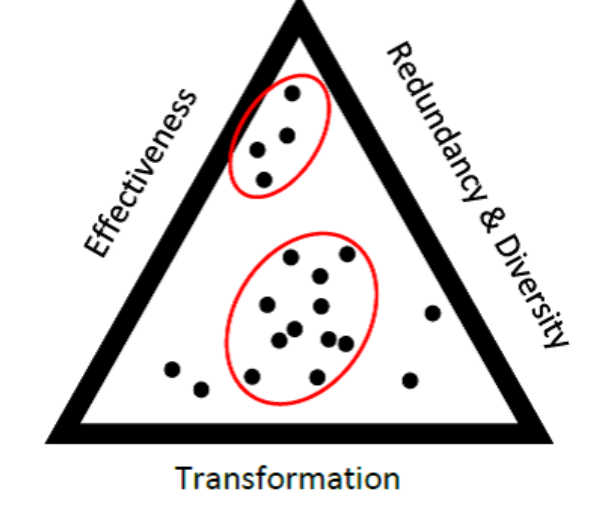
Fig. 2 . Three pathways toward sustainability indicating the direction of desired